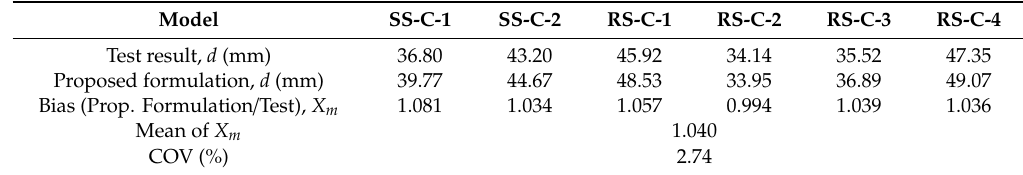
Table 9. Comparison of the proposed formulation results with the test